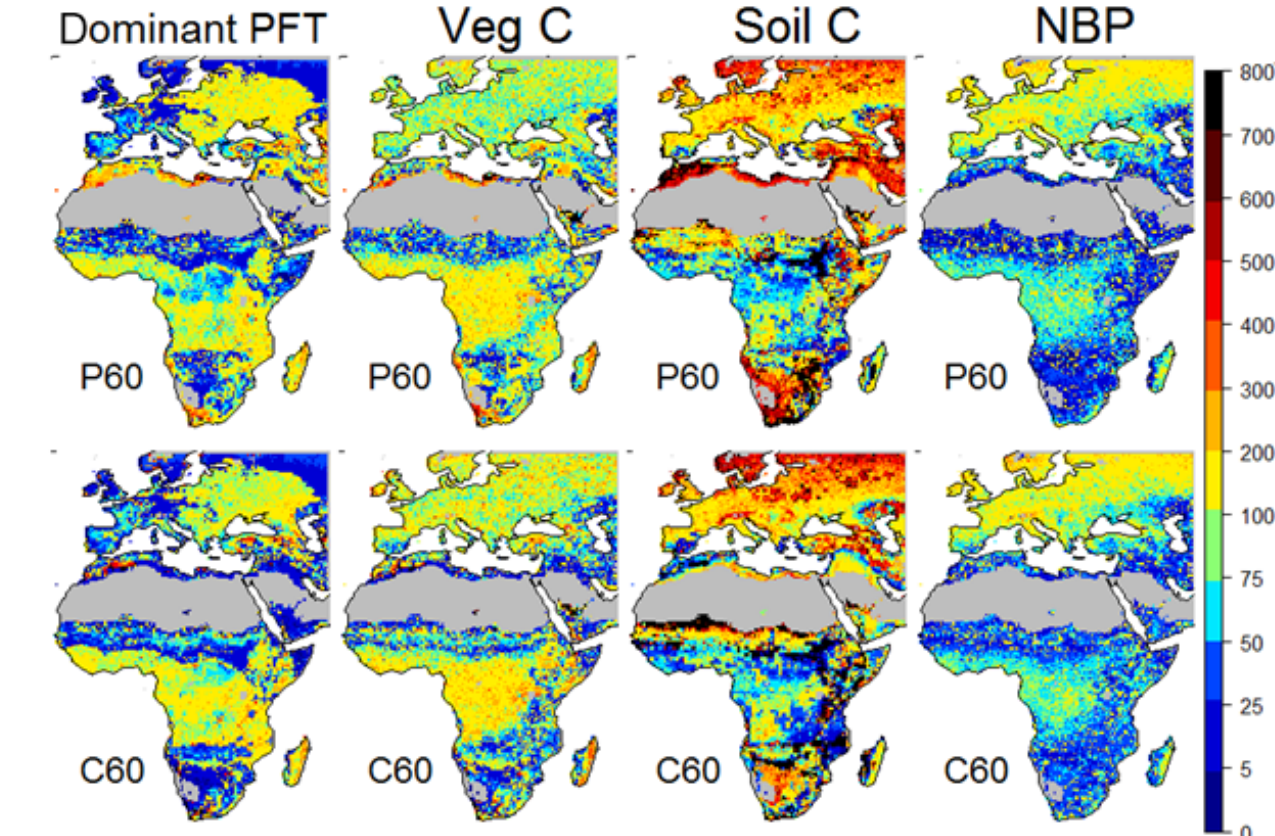
Figure A5. Maps of recovery time for the dominant PFT, vegetation C, soil C and NBP with an alternative recovery definition for the P60 and C60 simulations. The definition is the same as our standard definition but with a mean ± 1 σ threshold and the minimum check also applied to the maximum instead of a mean − 1 σ threshold and only checking the